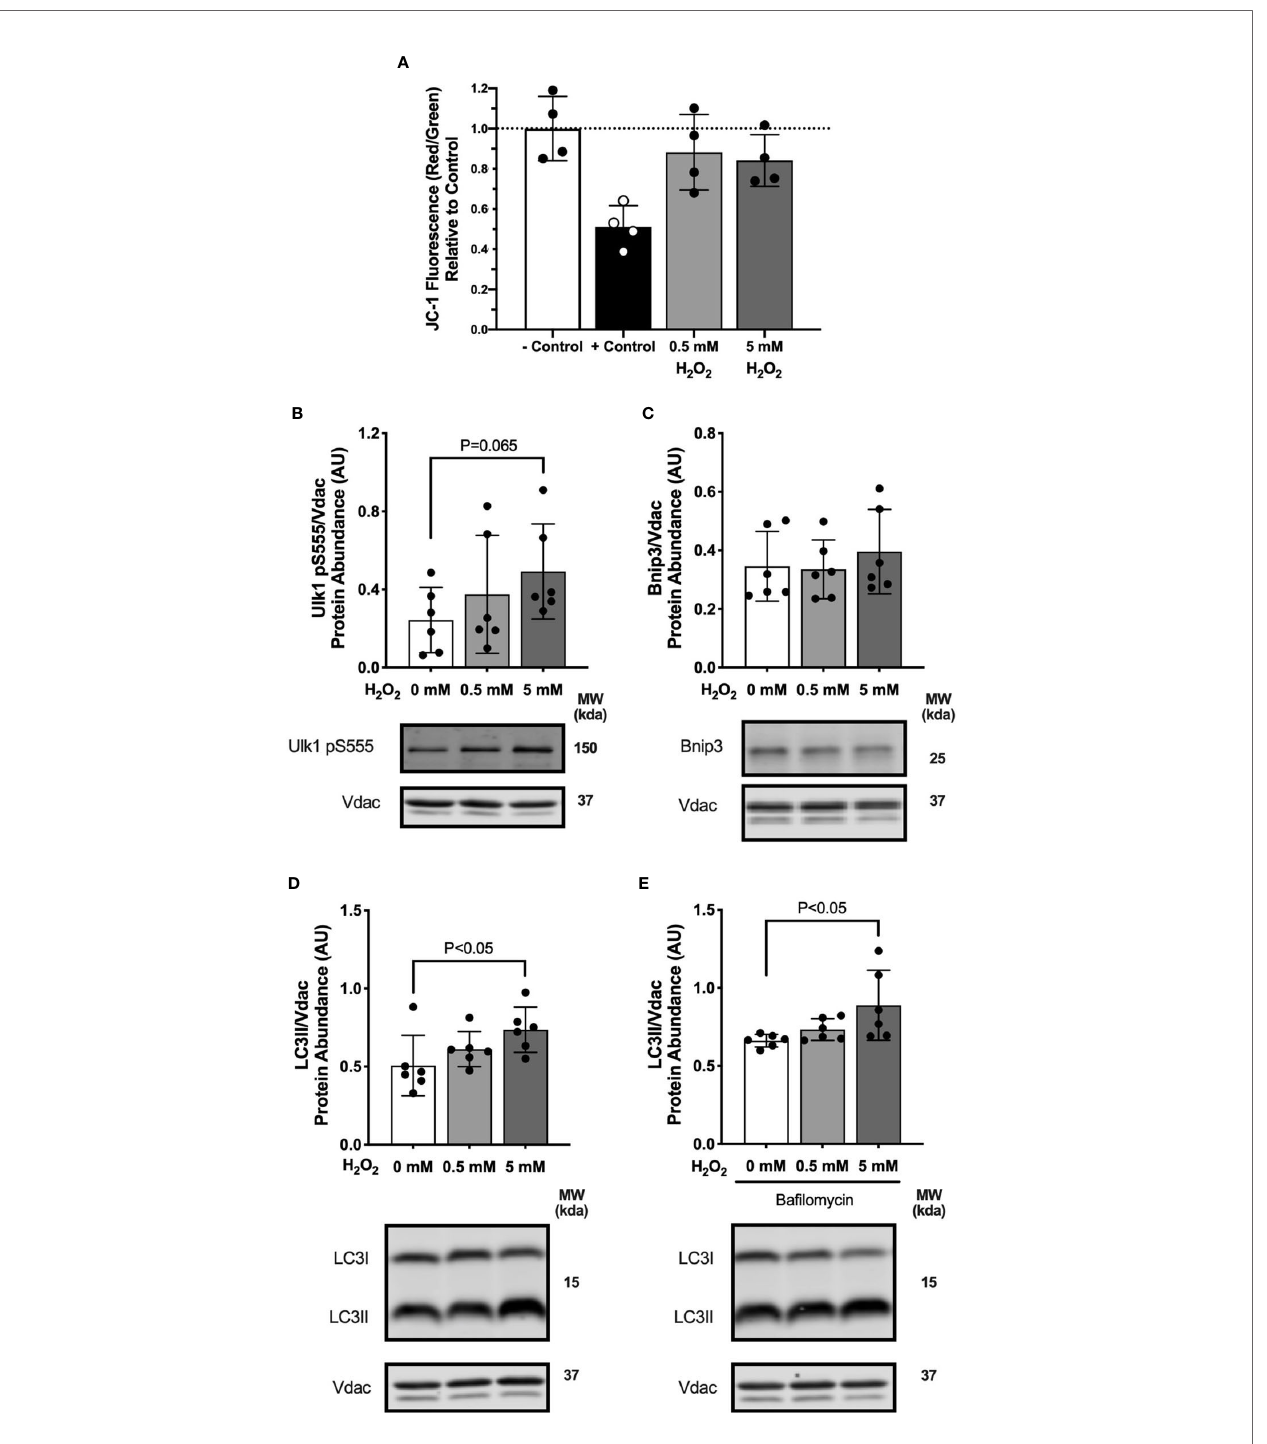
FIGURE 7 | Hydrogen peroxide treatment in myotubes activated mitophagy. Autophagy protein markers in C2C12 myotubes treated with speci fi ed concentrations of hydrogen peroxide for 1 hour. Cell lysates were fractionated to prepare a mitochondrial-enriched fraction and cytosolic fraction for immunoblotting. (A) JC-1 fl uorescence indicating mitochondrial membrane potential. – Control is DMED and + Control is FCCP. (B) Ulk1 pS555 protein abundance in mitochondrial fraction. (C) Bnip3 protein abundance in mitochondrial fraction. (D) LC3II protein abundance in mitochondrial fraction. (E) LC3II protein abundance in mitochondrial fraction in ba fi lomycin treated cells. Images below graphs are representative blot images. Protein targets in the mitochondrial fraction are normalized to Vdac abundance as a mitochondrial protein control. Panels (D, E) are from the same membrane. Data are means ± SD; n=6 for immunoblots and n=4 for JC-1. Unpaired t-tests were used to test for differences between